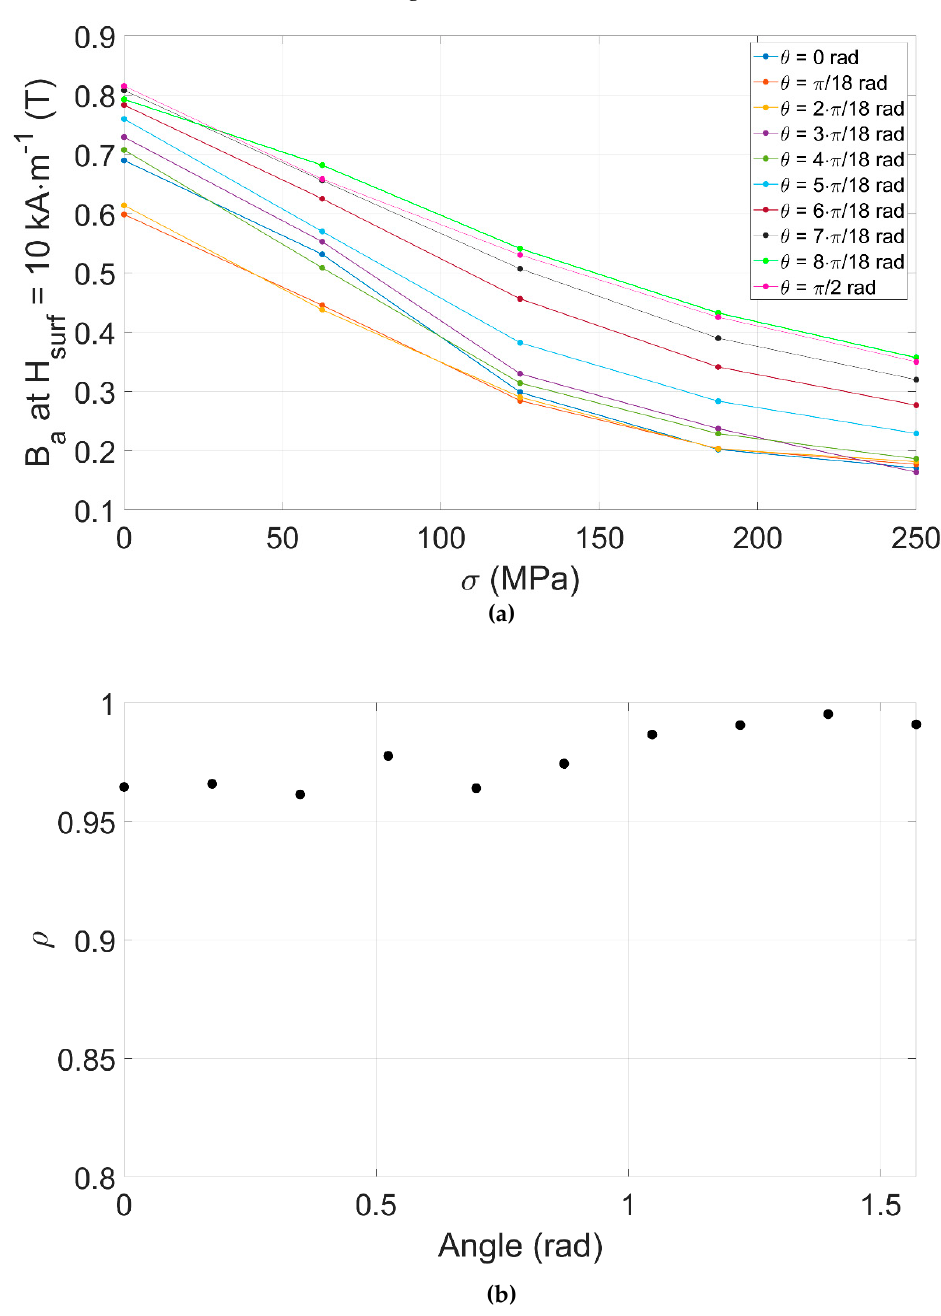
Figure 15. ( a ) B a at H surf = 10 kA ∙ m − 1 for θ in the [0, π /2] range. ( b ) Related Pearson correlation factors.